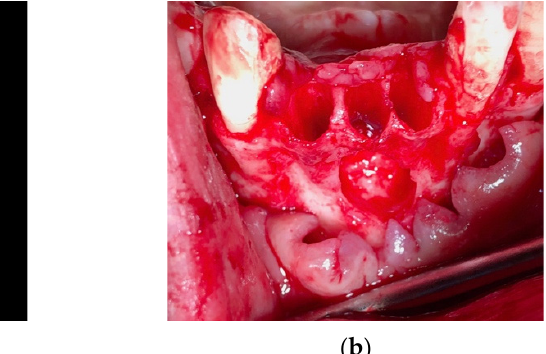
Figure 12. Prosthetic finalization of the case and mucose quality.